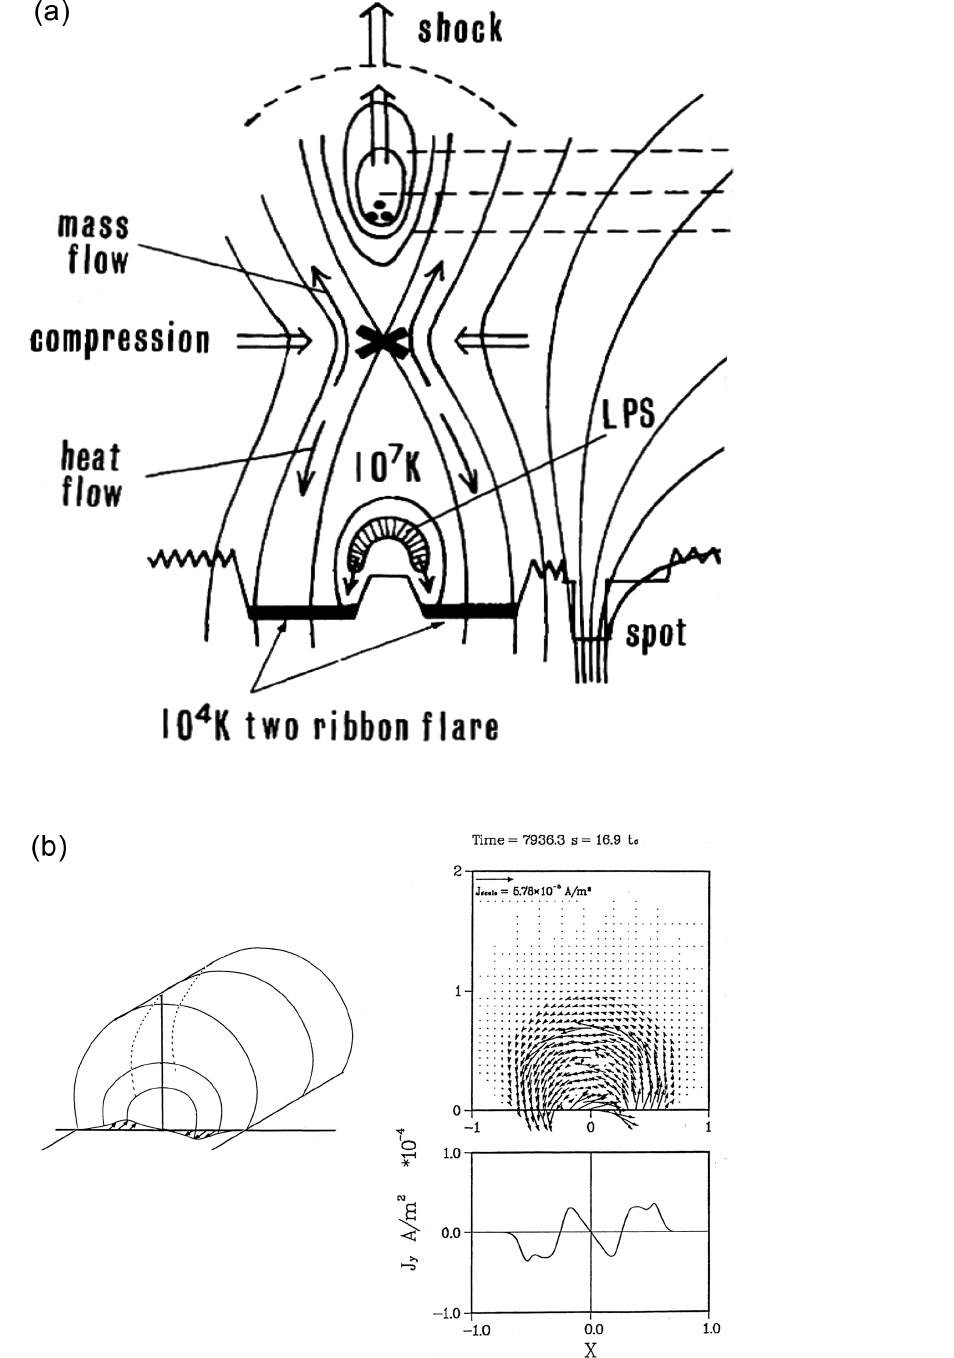
Figure 10. (a) A magnetic arcade–cusp model of solar flares (Hirayama, 1974). (b) The photospheric dynamo model developed by Choe and Lee (1996a,